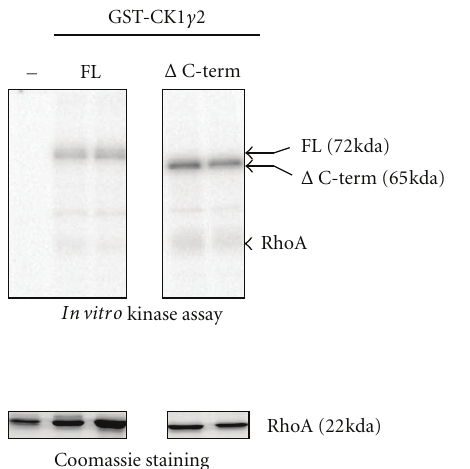
Figure 7: RhoA is not phosphorylated by CKI γ 2 in vitro . Recom- binant GST-CKI γ 2 full length (FL) or C-terminal truncated ( Δ C- term) (200ng) purified on beads was incubated with recombinant RhoA (1 μ g) in in vitro kinase assays. Incorporation of 32 P was revealed by autoradiography of the kinase reactions resolved on SDS-PAGE. Respective proteins are indicated, and equivalent amount of RhoA used in the assays was revealed by Coomassie blue staining.